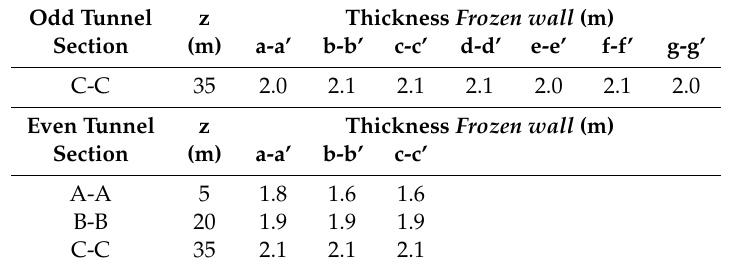
Table 4. Thickness of the frozen wall after 14 days of AGF with nitrogen liquid.